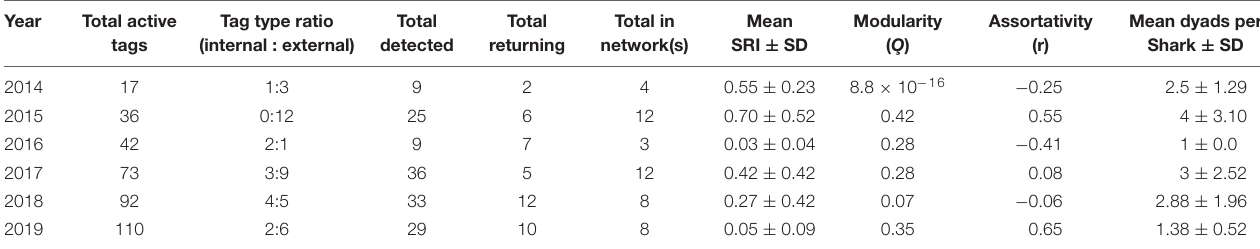
TABLE 2 | Summary table of characteristics of observed networks across individual